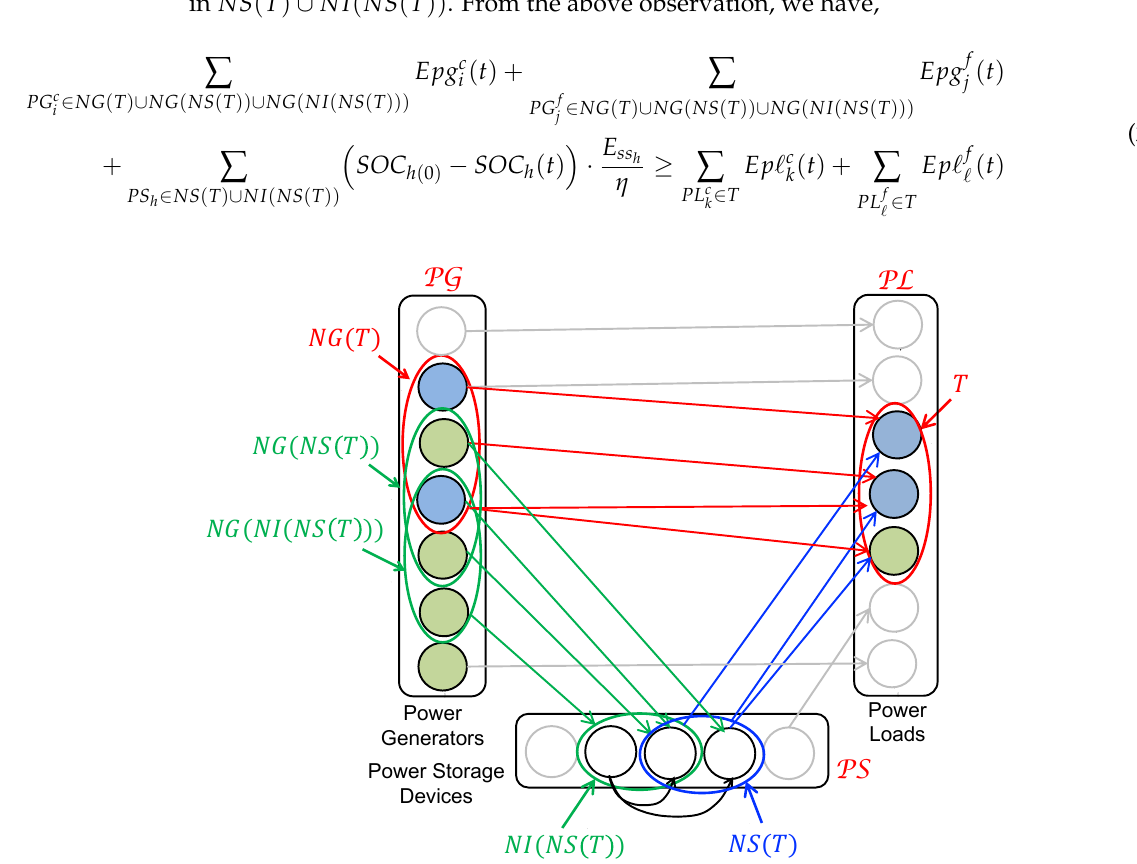
Figure 10. Power loads subset T and neighboring power